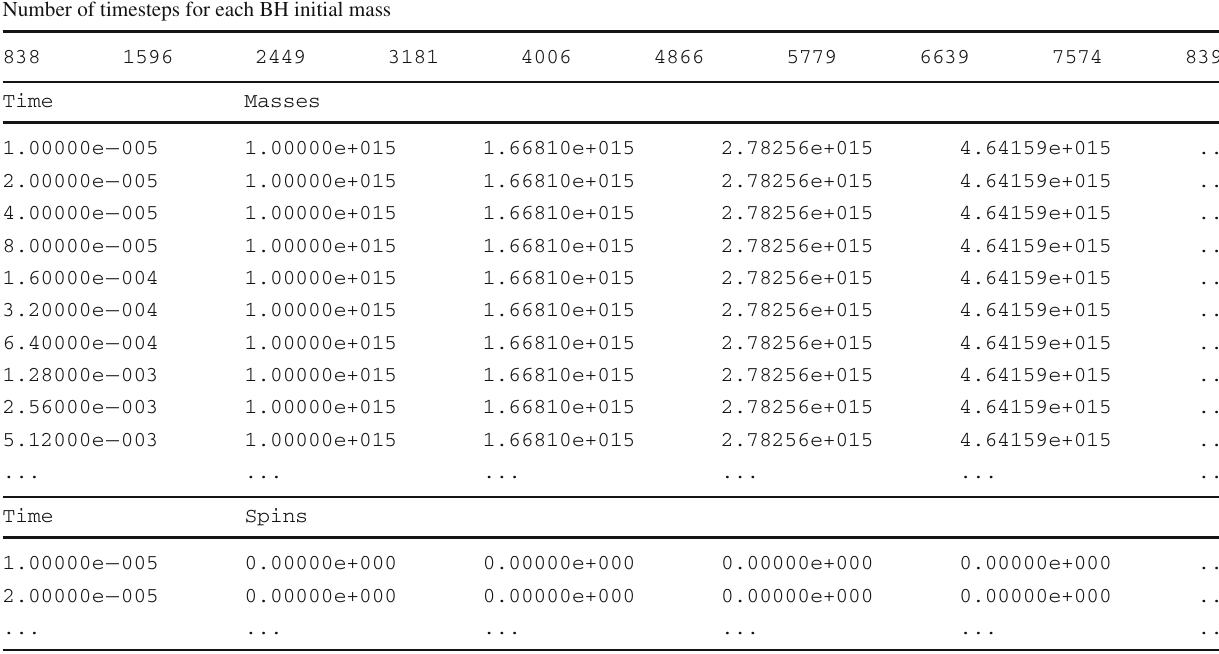
Table 6 Evolution of the BH masses and spins as functions of time Number of timesteps for each BH initial mass